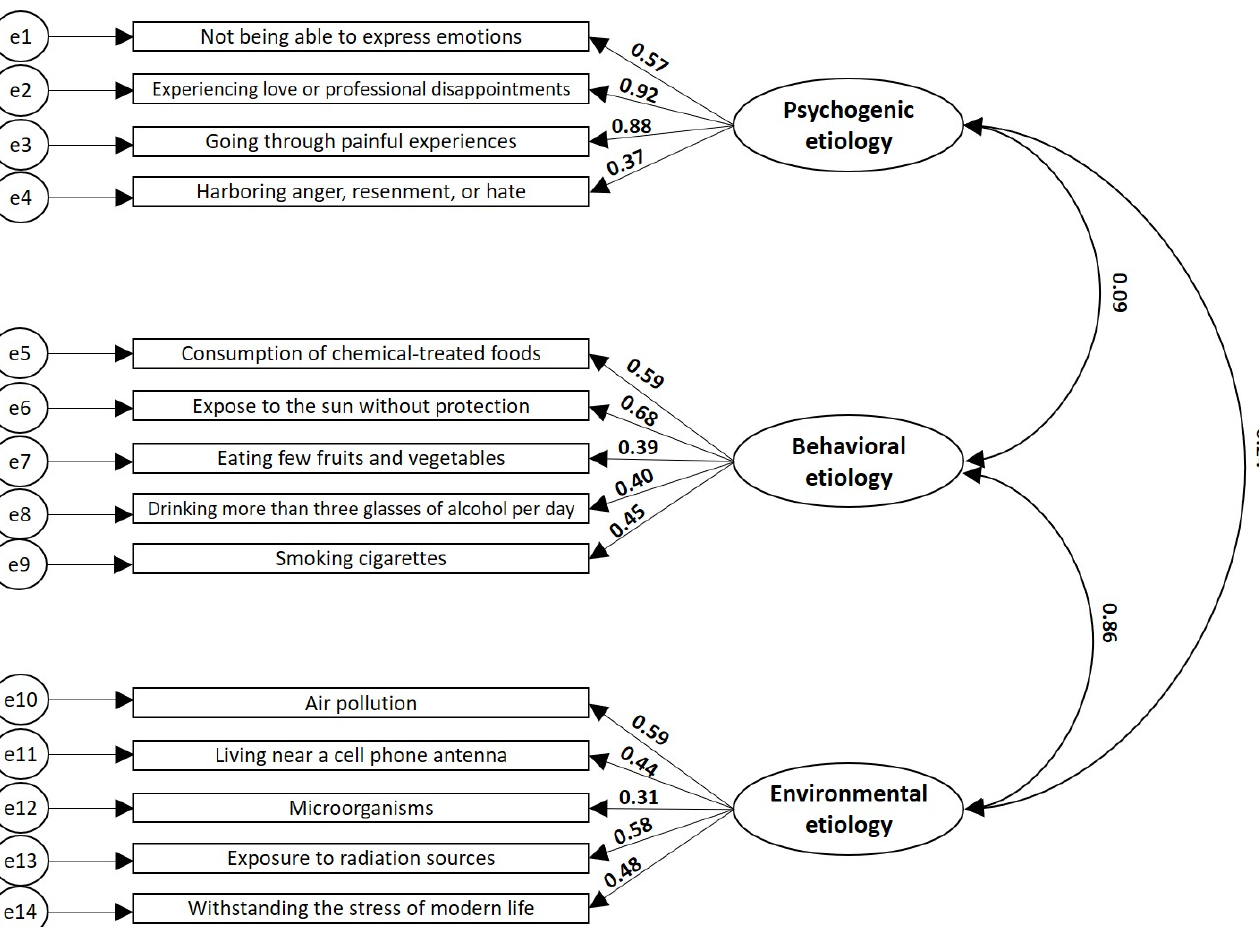
Figure 1. Explanatory model of the attributions to the etiology of cancer. The regression coefficients between the items (rectangles representing the observable variables) with the constructs (ovals representing the latent variables) and between the three constructs are shown. All data have p -values of <0.001. NFI 0.728, IFI 0.764, TLI 0.707, CFI 0.761, and RMSE 0.110.